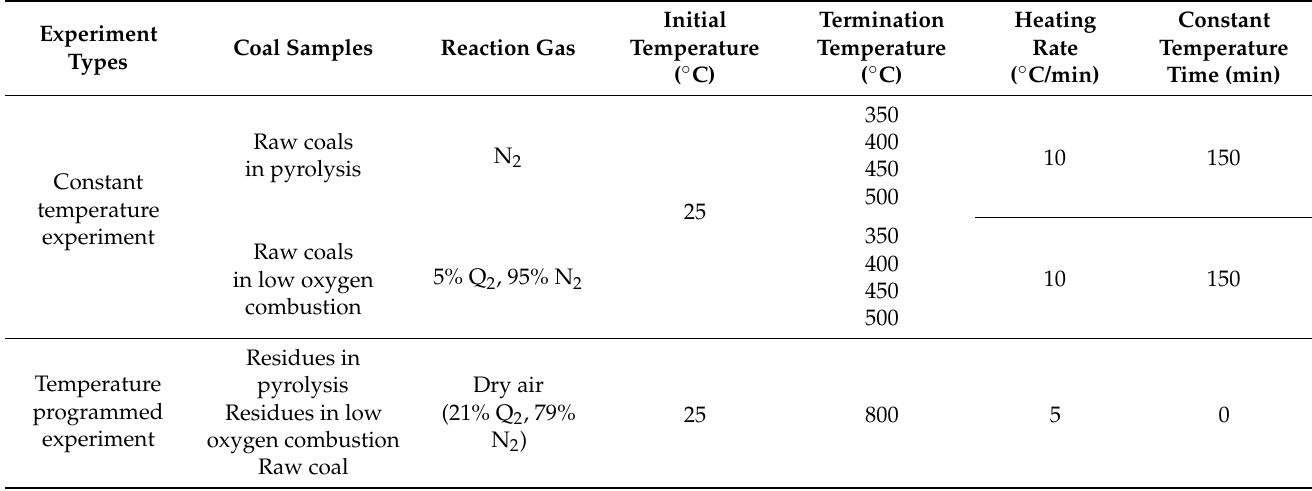
Table 2. The experiment